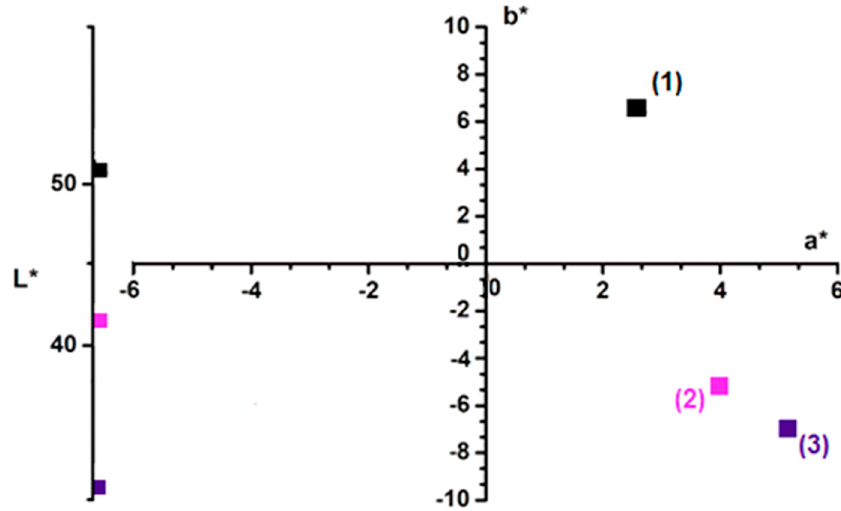
Figure 4. CIEL*a*b* color parameters of: (1) adsorbent before adsorption, (2) adsorbent after adsorp- tion and (3) crystal violet dye.